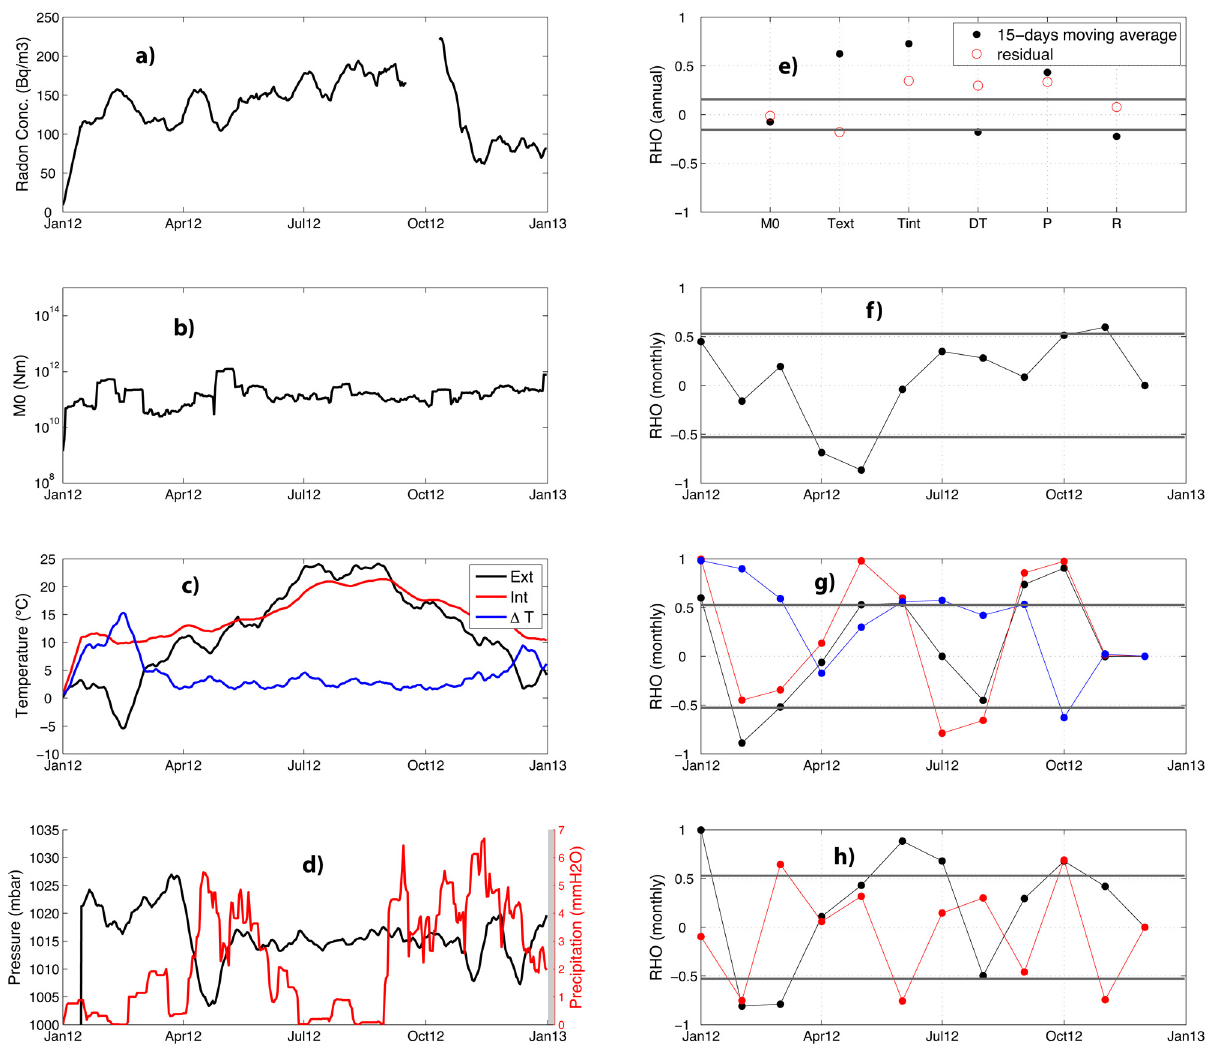
Figure 6. The same as in Figure 5, but between January 1, 2012 and December 31,